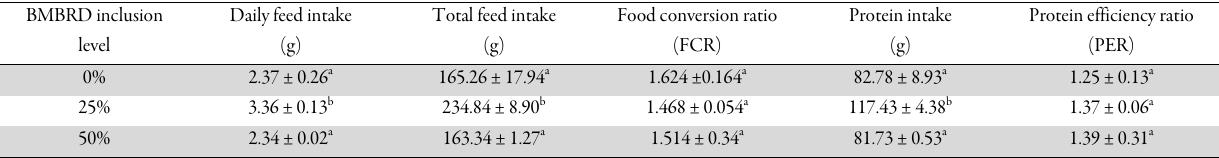
*Means within column with different superscripts are significantly different (p<0.05) from each other Table 6. Feed utilization in the fish fed the different experimental diets BMBRD Inclusion level